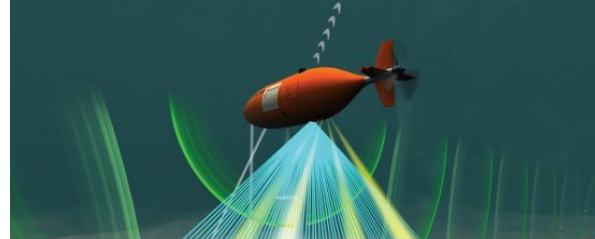
Figure 3: An AUV using MBE, SSS, and ADCP. MBE: blue beams, SSS: Green waves, and ADCP: yellow beams . Image courtesy of Fugro Sur- vey Ltd. (http://www.fugrosurvey.co.uk). can sonar (SSS), and acoustic Doppler current profiler